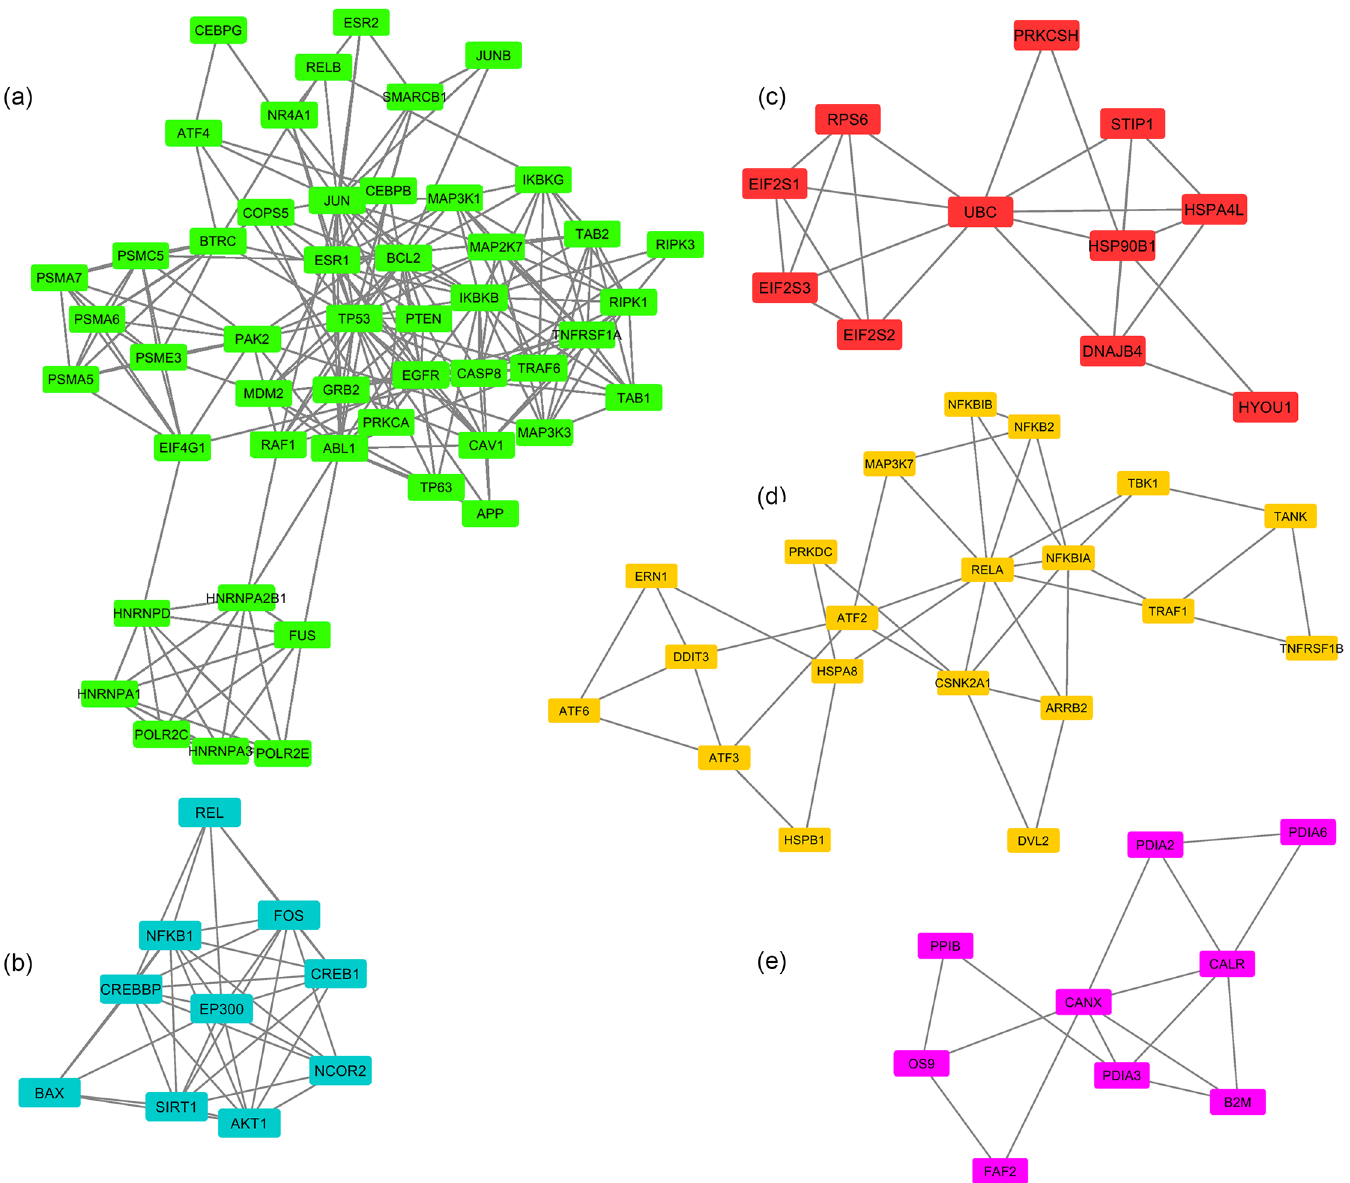
Fig 1. Clusters of intersection network identified by MCODE plugin. a Cluster 1, b Cluster 2, c Cluster 3, d Cluster 4 and e Cluster 5.